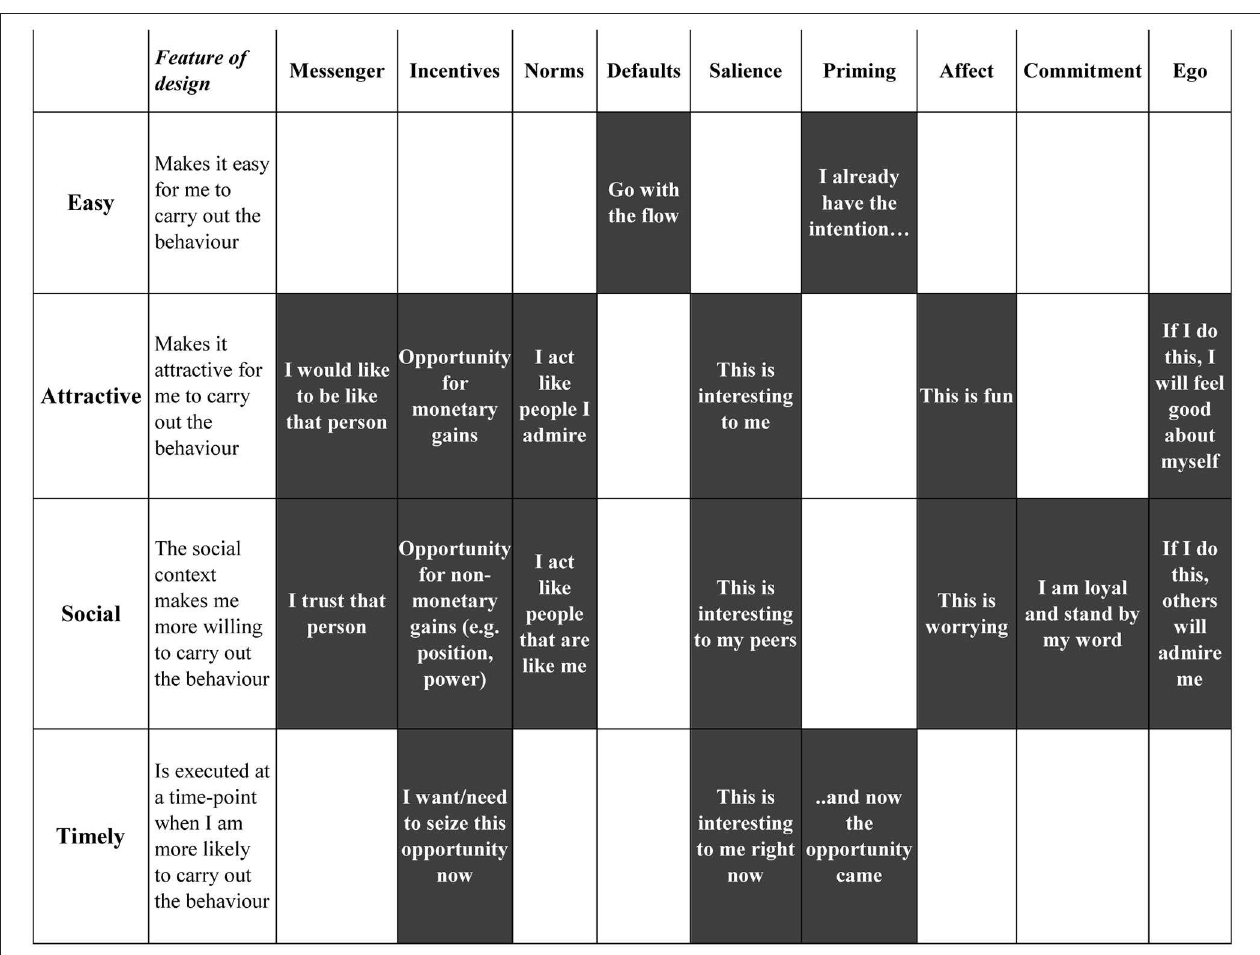
FIGURE 2 | Interpretation of the relationships between EAST (Easy, Attractive, Social, and Timely) attributes and MINDSPACE (Messenger, Incentive, Norms, Default, Salience, Priming, Affect, Commitment, and Ego) psychological mechanisms in animal health interventions.